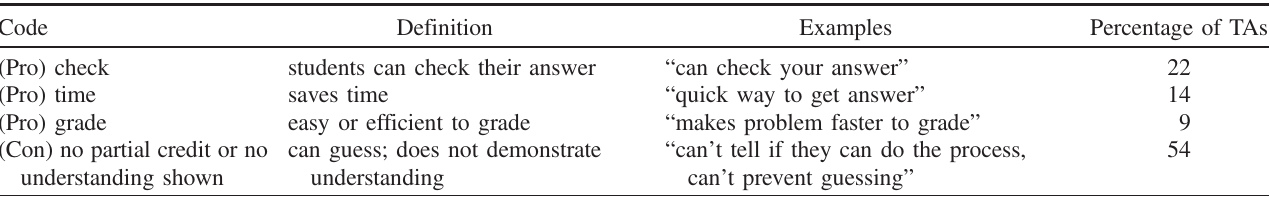
TABLE I. The most commonly listed pros or cons of the multiple-choice problem type and the percentages of TAs who listed them. Some TAs listed more than one of the following or other pros or cons not listed here.